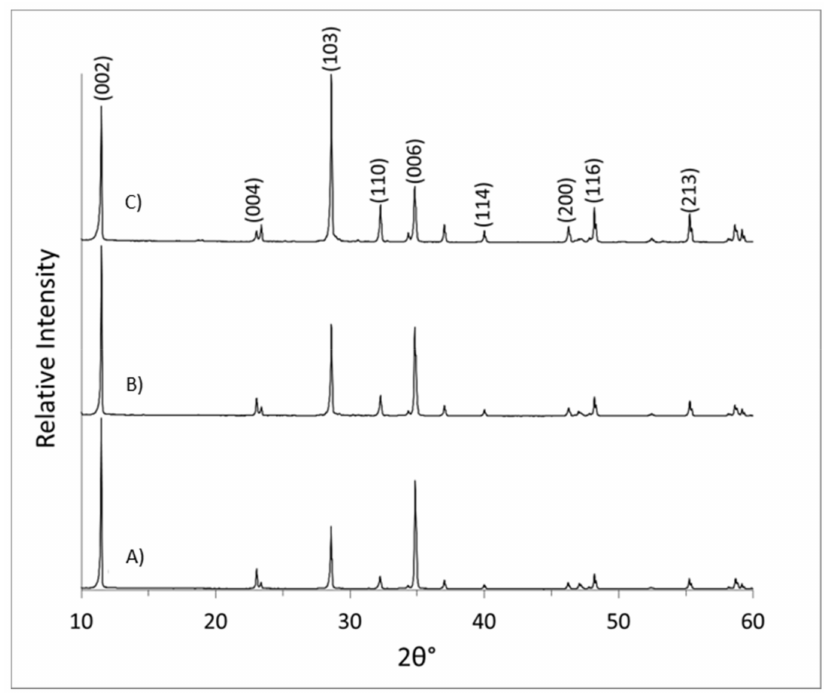
Figure 4. XRD pattern of BICUTIVOX platelets produced via MSS: (A) 650 ◦ C/8 h, (B) 675 ◦ C/8 h, (C) 700 ◦ C/8